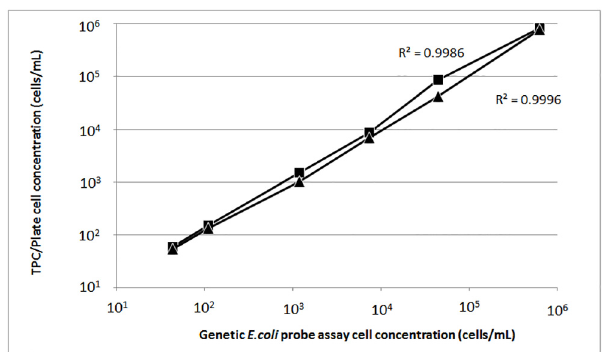
Fig 5. Linearity of generic E . coli probe assay. Cell culture was diluted over 6 orders of magnitude and equal volume of each dilution were assessed by generic E . coli probe assay, TPC assay and agar plate counting. The sensitivity of the R-squared value between genetic probe assay and TPC assay ( & ) is 0.9986, and the R-squared value between genetic probe assay and agar plate counting ( ▲ ) is 0.9996. Each data point is an average of 3 repeats.